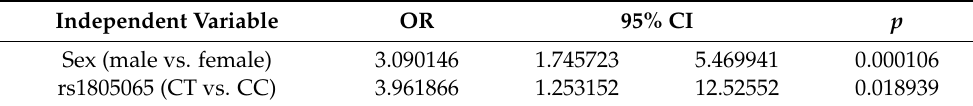
Table 3. Multivariate logistic regression analysis of independent factors associated with high elite martial athlete performance as dependent variable (high elite martial athletes vs. controls). Independent Variable OR 95% CI p Sex (male vs. female) 3.090146 1.745723 0.000106 rs1805065 (CT vs.